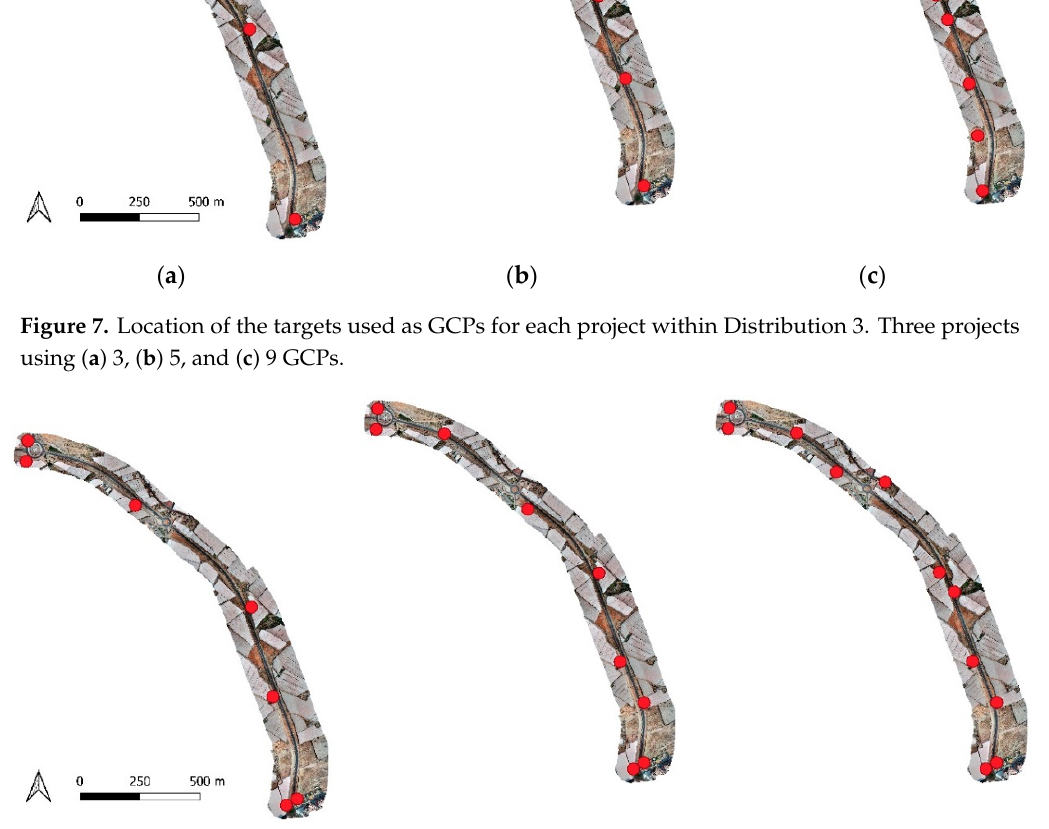
Figure 8. Location of the targets used as GCPs for each project within Distribution 4. Three projects using ( a ) 7, ( b ) 9, and ( c ) 11 GCPs (red dots) were carried out.